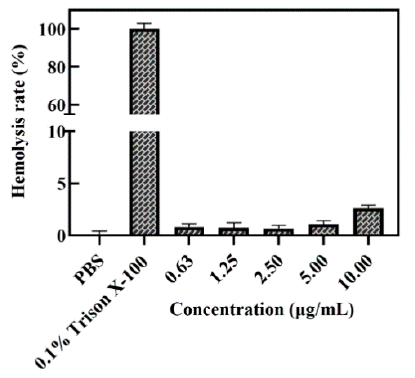
Figure 6. Hemolysis histogram of 0.1% Triton X-100 (positive control), PBS (negative control), and different concentrations of A-BG-DOX.